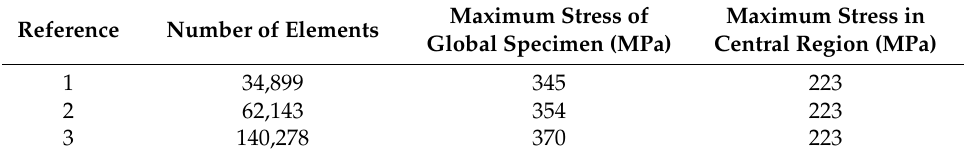
Table 4. Mesh sensitivity analysis on